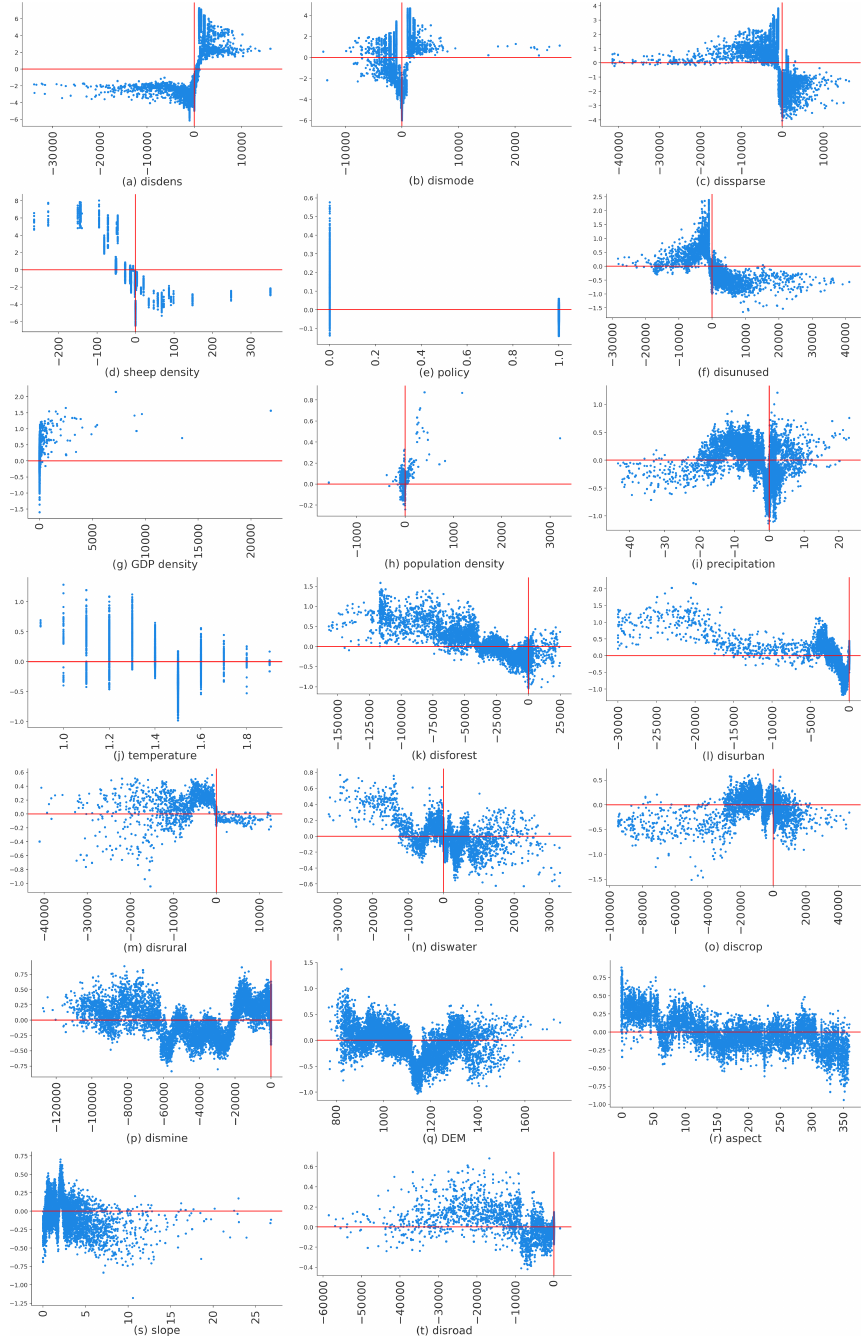
Sheep density was identified as the fourth major